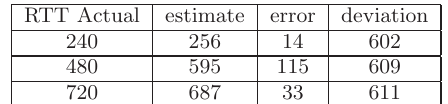
Table 2: RTT statistics comparison (inches)